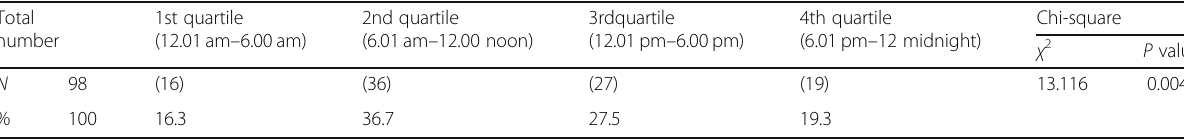
Table 1 Circadian variation of stroke